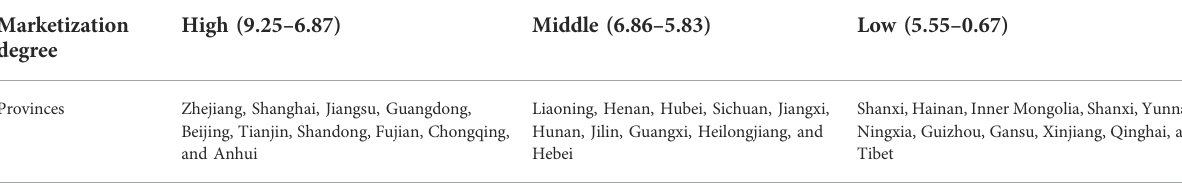
TABLE 10 Distribution of provincial marketization degree (average value from 2009 to 2017).